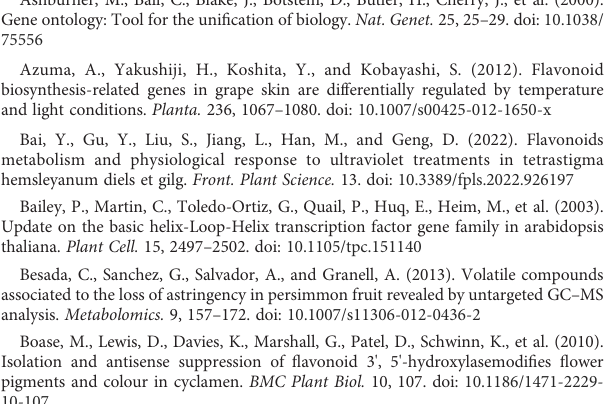
Principal component analysis score plot of all metabolites in mature PCNA and PCA persimmon fruit.